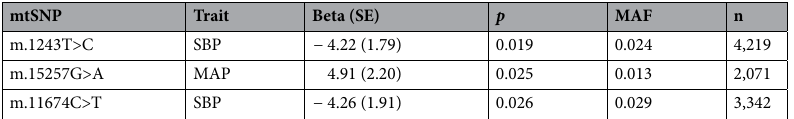
Table 2. Three most significant associations in the sex-combined meta-analysis. mtSNP mitochondrial single-nucleotide polymorphism, Trait the trait used for a specific test, Beta (SE) beta coefficient and the corresponding standard error, p unadjusted p -value from meta-analysis, MAF minor allele frequency, n sample size contributing in a particular mtSNP